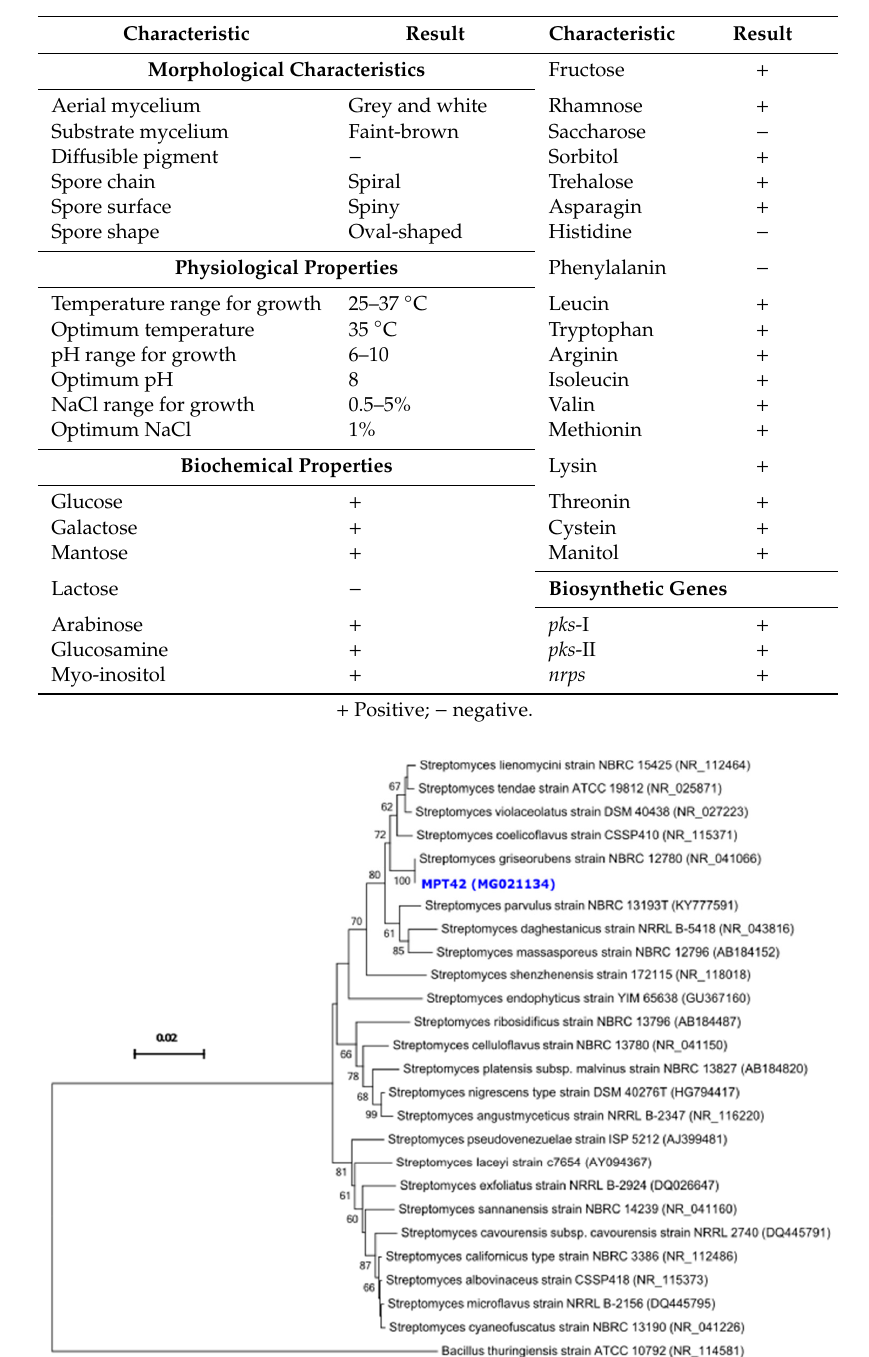
Table 2. Physiological and biochemical characteristics of the actinomycete MPT42.